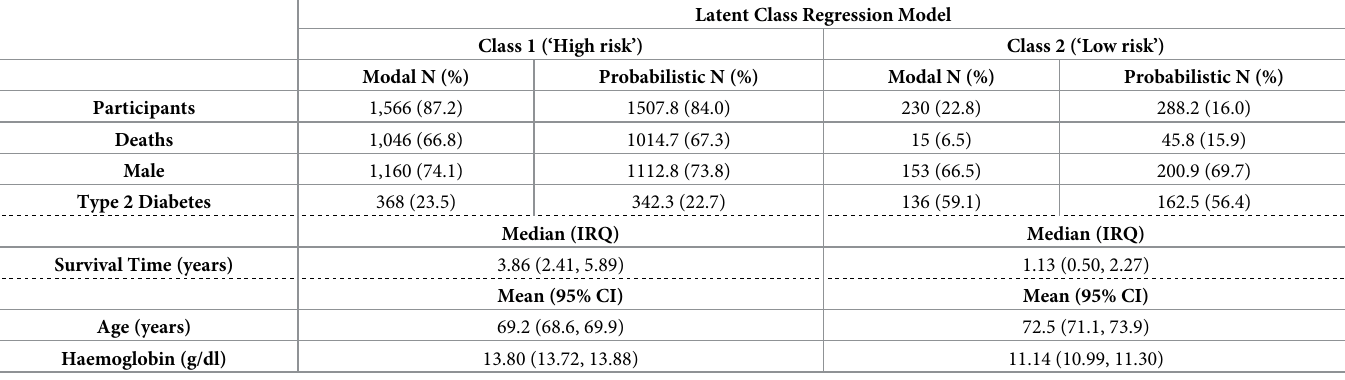
Table 4. Descriptive characteristics for the 2-class Cox proportional hazards latent class regression model.